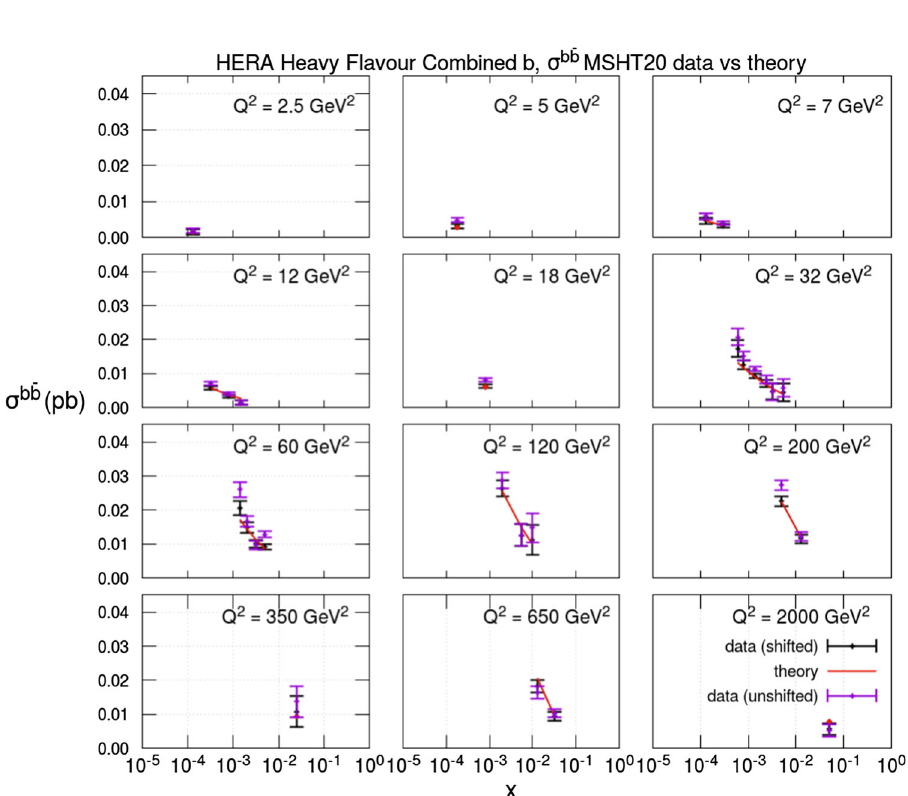
Fig. 5 As in Fig. 4, but for the bottom